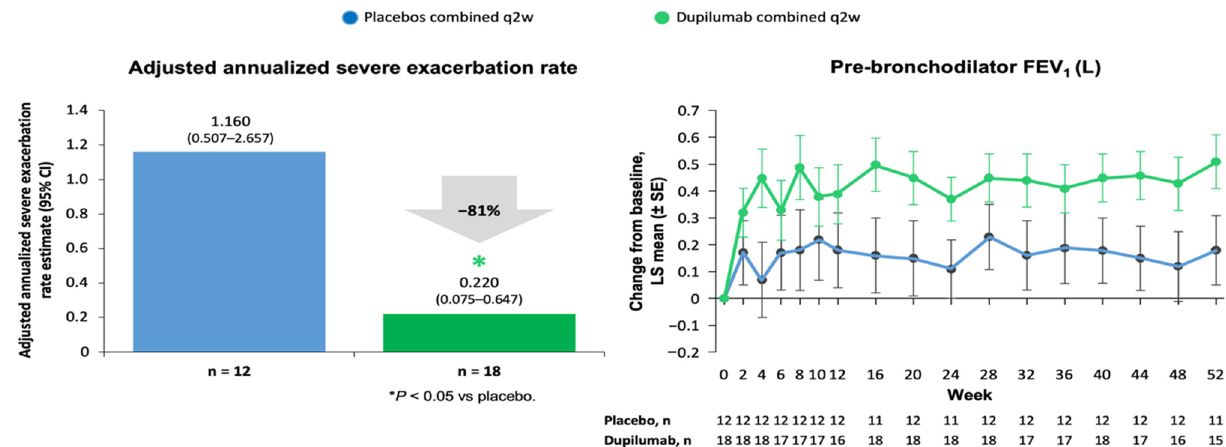
Figure 4. Clinical outcomes of annualized severe asthma exacerbation rate ( left panels ) and change in lung function ( right panels ) in a randomized, double-blind, placebo-controlled one-year pivotal trial of dupilumab in adult patients with moderate-severe asthma. Top panel : Results of overall study. Dupilumab reduced asthma exacerbations by 46–48% and improved lung function (*** p < 0.001) in both dosage arms of active treatment compared to placebo. Bottom panel : Post hoc analysis of study subjects with serologic ABPA (IgE > 1000 IU/mL, Af-specific IgE > 0.35 IU/mL, eosinophil count > 500) showing pooled results for actively treated subject arms compared to placebo. Dupilumab treatment reduced exacerbations and improved lung function to an even greater degree than seen in the overall study results. Adapted from references [80,82].